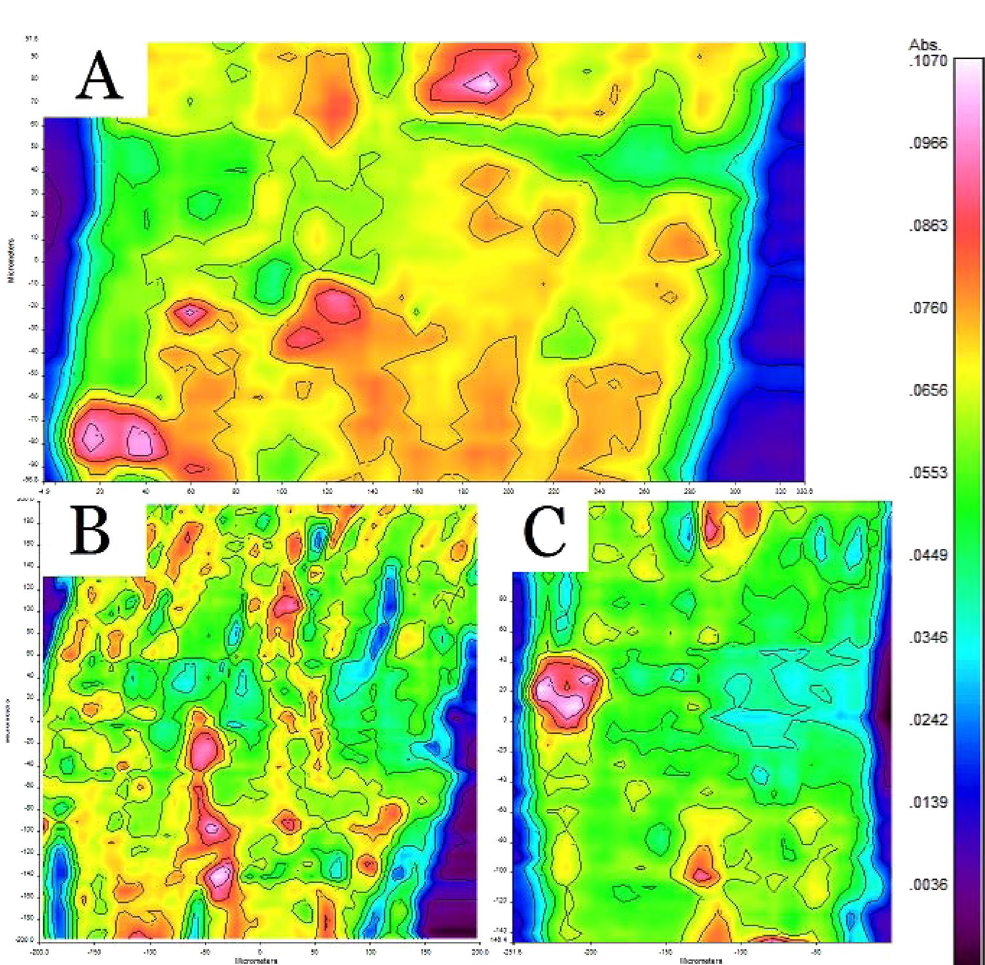
Figure 3. Lignin infrared microspectral images. ( A ) raw kenaf fiber bundle, ( B ) semi-degummed fiber bundle and ( C ) degummed fiber